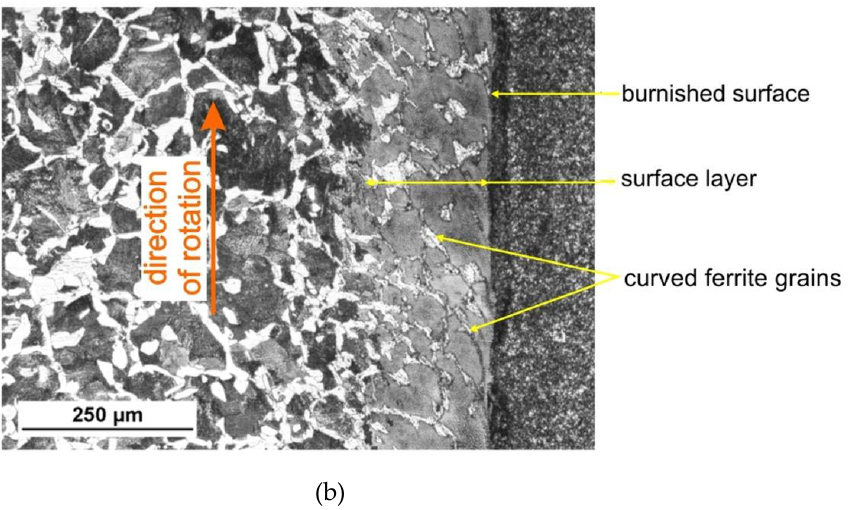
Figure 13. Structure of the plastically deformed surface layer of specimen burnished with braking moment: ( a ) magnification ×200, ( b ) magnification ×500.